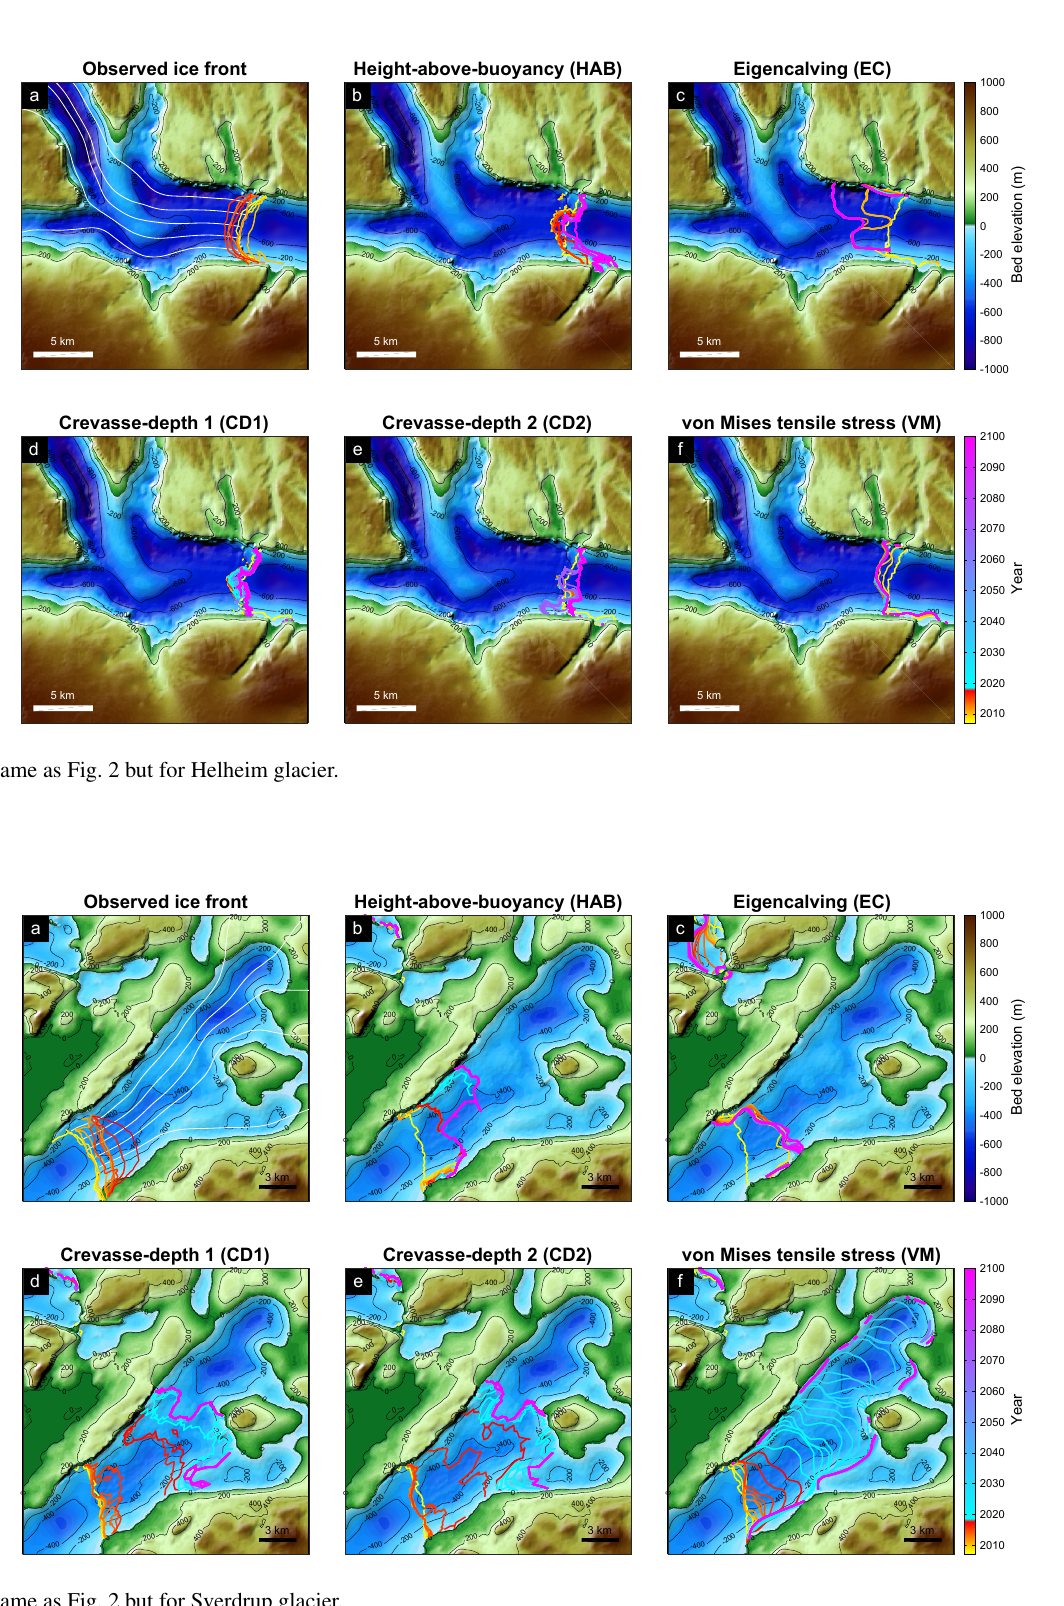
Figure 5. Same as Fig. 2 but for Sverdrup